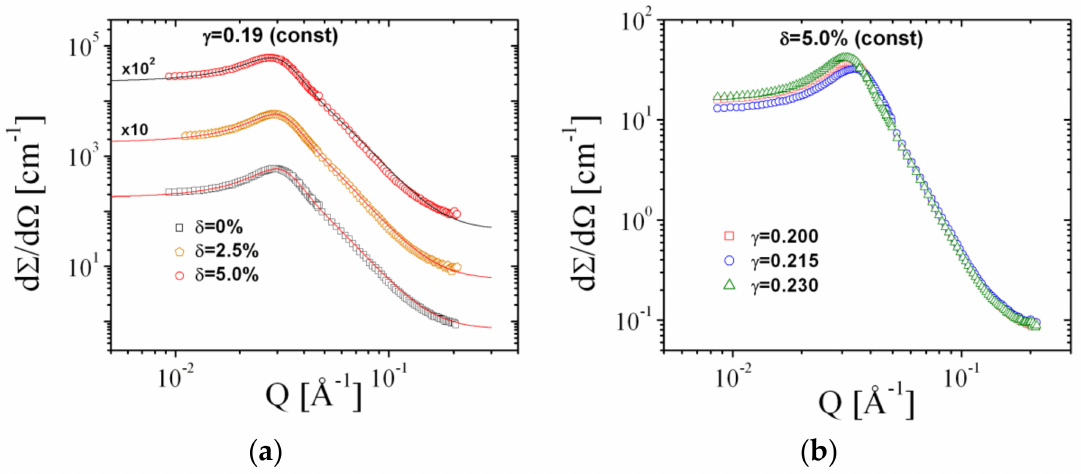
Figure 7. Small-angle neutron scattering (SANS) curves from Comb 4 with ( a ) di ff erent amounts of polymer and ( b ) with di ff erent amounts of surfactant. All curves are fitted with the Teubner–Strey model (Equation (11)). Statistical errors are within the symbol